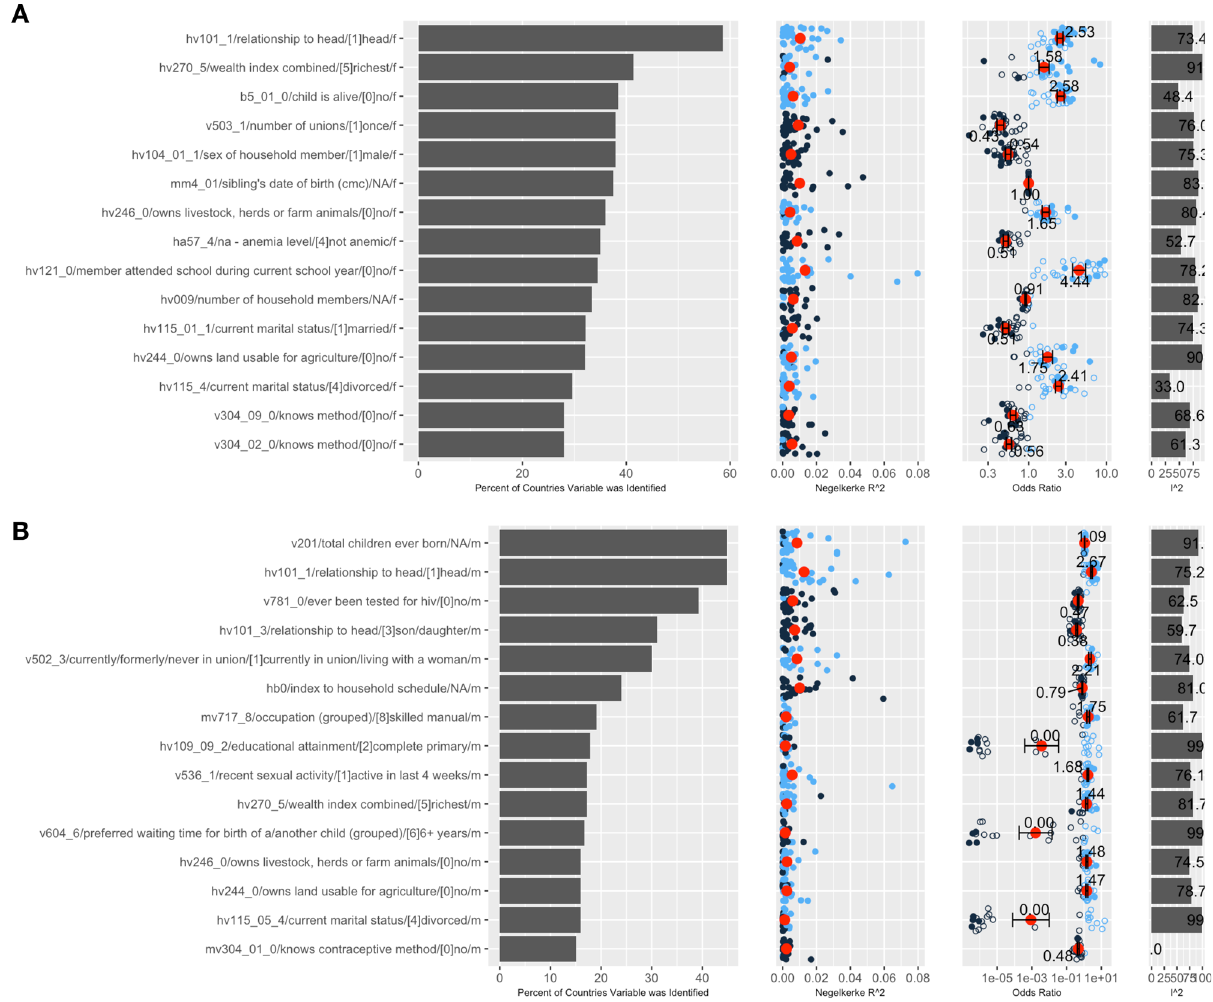
Fig. 2 Top 15 variables identi fi ed across 21 – 29 countries. A Top 15 variables in females and ( B ) Top 15 variables in males. Left most panel is the variable name and code name, 2nd panel from left is the percent of countries variable was identi fi ed, 3rd panel from left is the Nagelkerke R2 per country (red dot is the average; blue points are countries with OR > 1, dark blue are countries with OR < 1), 4th panel shows the odds ratios (overall meta-analytic estimate in the red dot), and 5th panel shows the I2 (heterogeneity). Error bars denote 2 times the standard error of the coef fi cient, which was estimated using a random-effects model. All data to reproduce fi gures, including the standard errors, can be found in Supplementary Data 1. The sample sizes (number of surveys) for the overall odds ratio (red) are in Supplementary Data